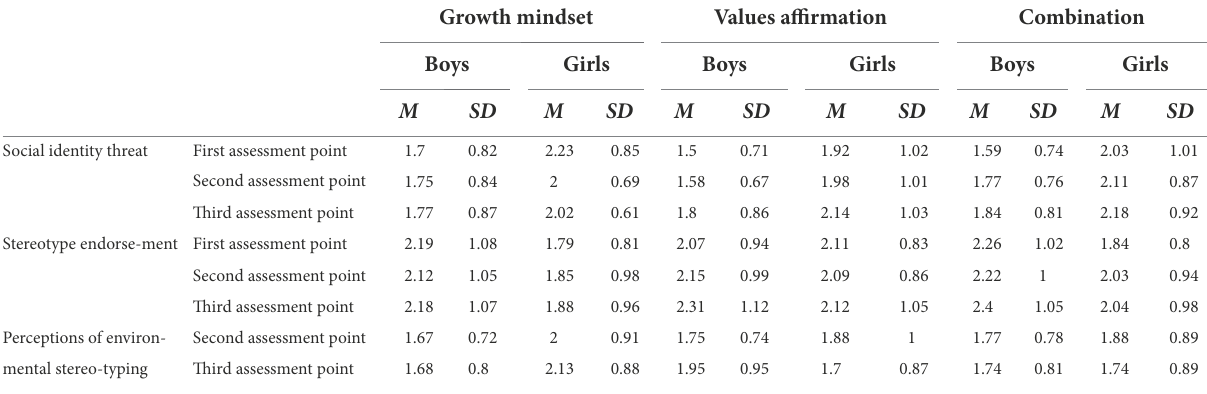
TABLE 4 Means and standard deviations of perceived social identity threat, stereotype endorsement, and perceptions of environmental stereotyping for the first three measurement points, split by gender and intervention